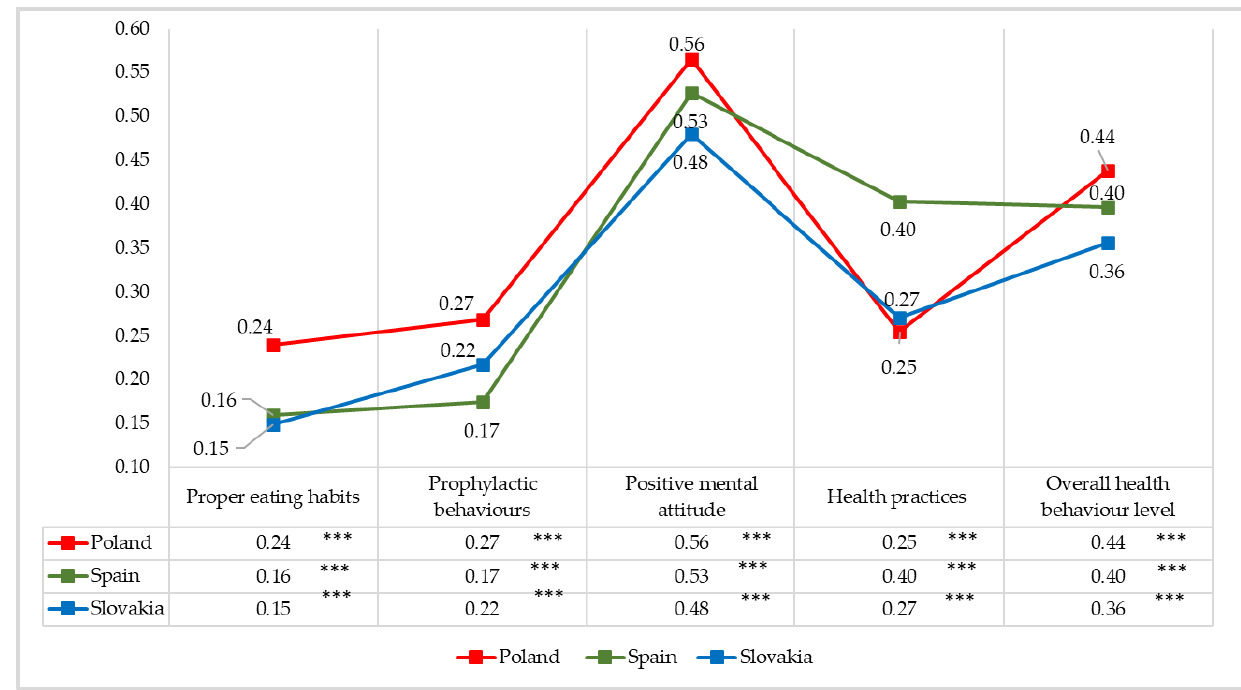
Figure 5. The nature and power of correlation between the intensity of dispositional optimism and health behaviours in the study participants — Pearson correlation coefficients (r). Statistically signif- icant; *** p < 0.001. significant; *** p <